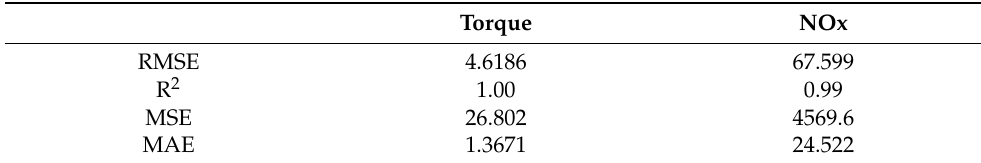
Table 4. Engine torque and NOx raw emission fitting result.